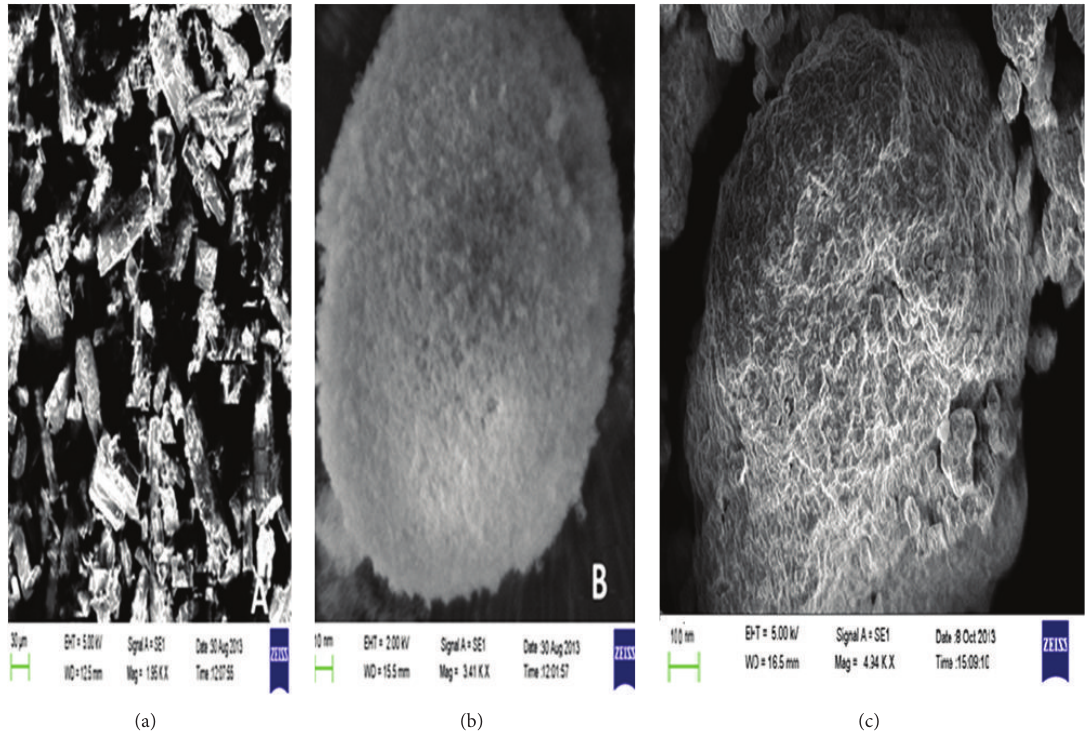
Figure 6: Scanning electron microscopy (SEM) images of CUR (a), Aerosil 200 (b), and optimized formulation (SP2)